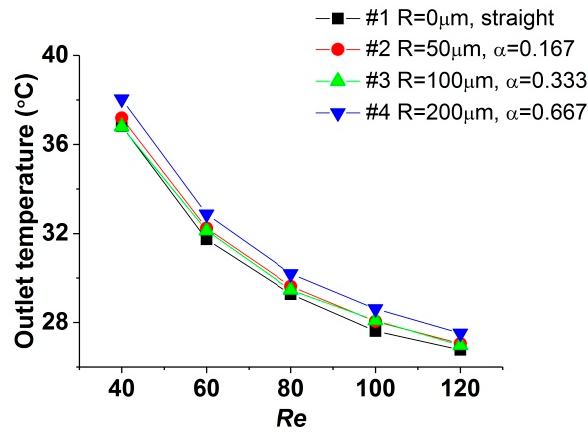
Figure 3. Influence of 𝛼 on outlet temperature.